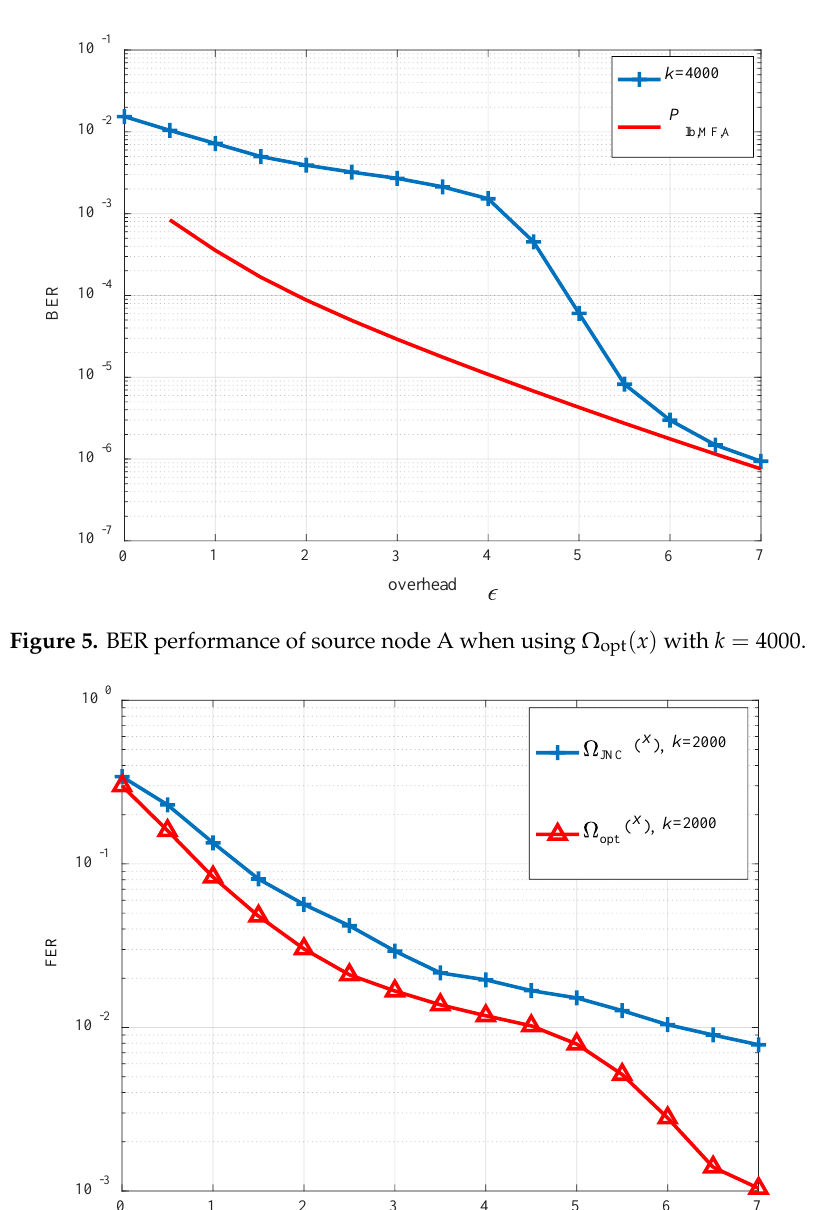
x with =2000 k . opt